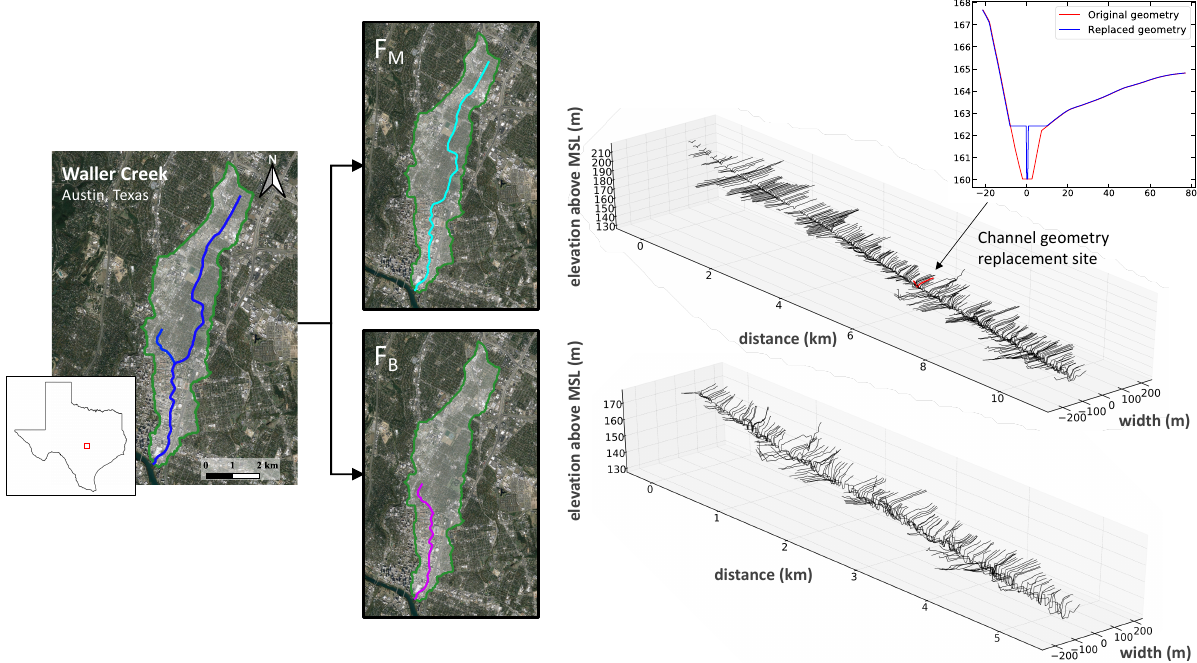
Figure 4. In the preprocess procedure of SSA method, Waller Creek is decomposed to two flowpaths, F M and F B . The corresponding channel geometries of each flowpath are also shown (river geometry survey data courtesy of the City of